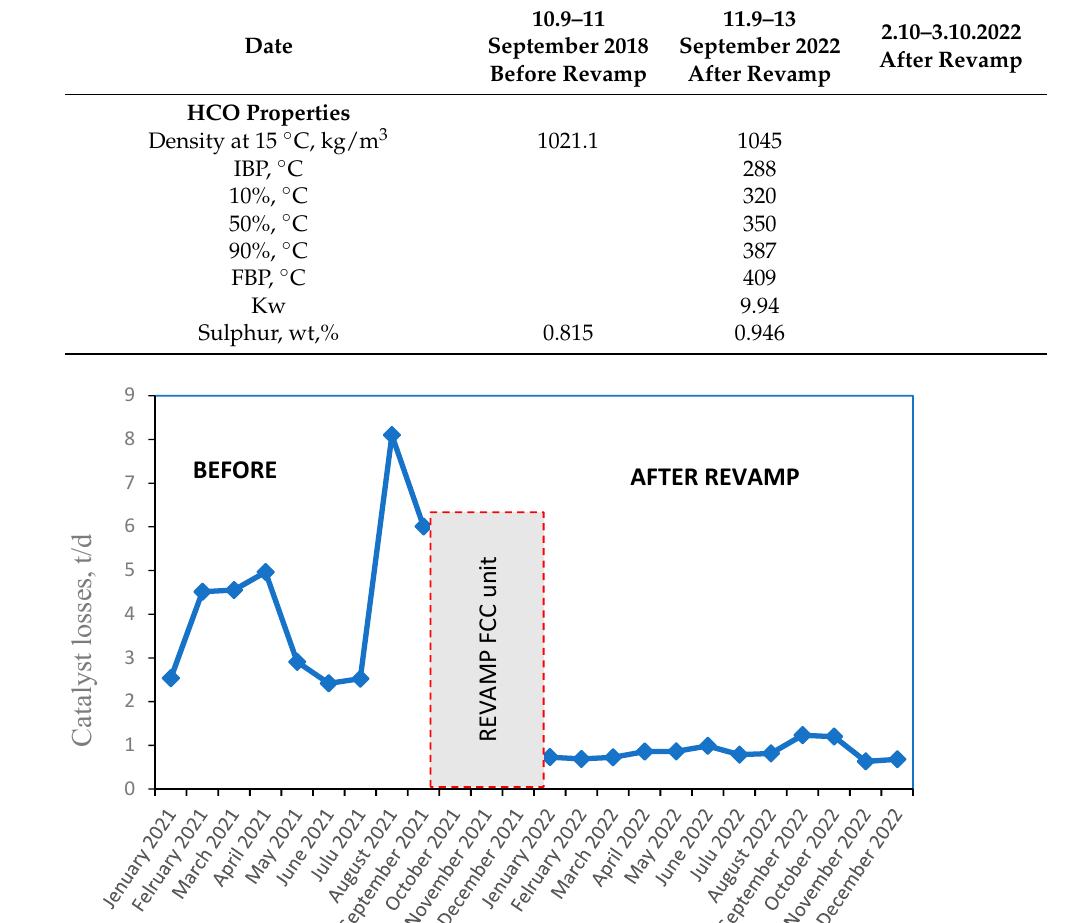
Figure 3. Variation in catalyst losses before and after the revamp of the LNB FCCU.